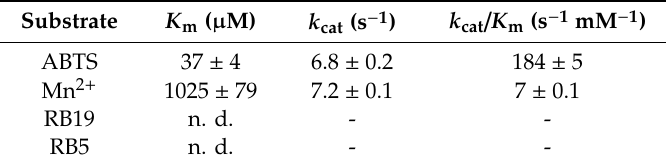
Table 1. Michaelis constants ( K m ), catalytic constants ( k cat ), and catalytic e ffi ciencies ( k cat / K m ) for PsaPOX using ABTS, Mn 2 + , Reactive blue 19 (RB19), and Reactive black 5 (RB5) as substrate. Values are the average of triplicate experiments with indication of standard